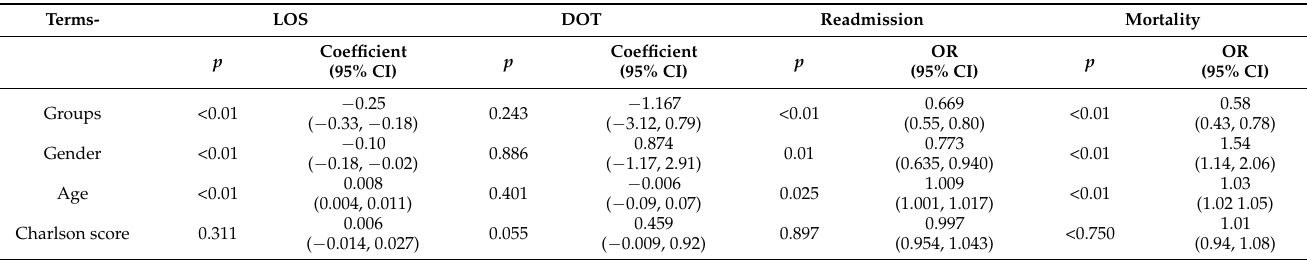
Figure 2. ASP recommendations for the non-intervention and intervention groups. The unadjusted regression (not adjusted for age, gender, and Charlson score) analysis of the clinical outcomes for different ward settings showed medical wards had significant differences ( p < 0.01) for all clinical outcomes except for the DOT ( p = 0.201), as shown in Table S1. The results of multiple regression (adjusted for age, gender, and Charlson score) analysis, comparing the non-intervention group with the intervention group in the medical setting, is shown in Table 2. The following outcomes, adjusted for age, gender, and Charlson score were shown to significantly improve in the intervention period: LOS (coefficient = − 0.25, p < 0.01), readmission ( p < 0.01; OR = 0.67; 95% CI = 0.55, 0.80), and the reduction was statistically insignificant (coefficient = − 1.17, p = 0.243). Table 2. Multiple regression analysis comparing non-intervention with ASP MDT intervention groups in a medical